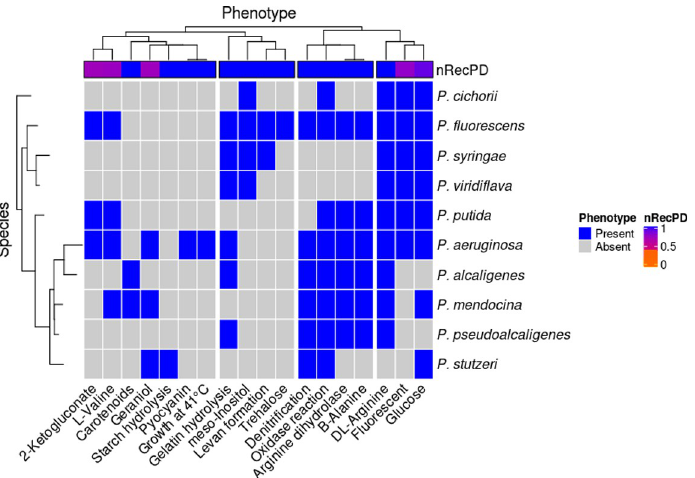
Fig 8. nRecPD indicates largely vertical descent of Pseudomonas spp. growth phenotype distributions, revealing clade specific loss-patterns and between-clade recombination. A heatmap showing presence / absence profiles of 10 growth phenotypes assayed over 10 representative strains of the genera Pseudomonas . Growth phenotype columns are hierarchically clustered and split into 4 major clusters, while species are arranged according to a 16S rRNA phylogenetic tree. Corresponding nRecPD values calculated for each growth phenotype are indicated by the top horizontal annotation strip, with blue indicating vertical descent (nRecPD = 1) and purple indicating signatures of recombination (nRecPD ~